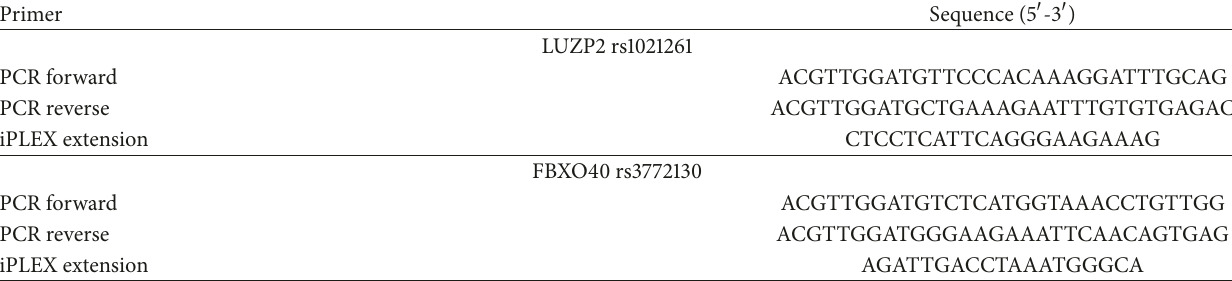
Table 1: PCR and iPLEX primers used for genotyping of rs1021261 and rs3772130 by multiplex PCR and MALDI-TOF mass